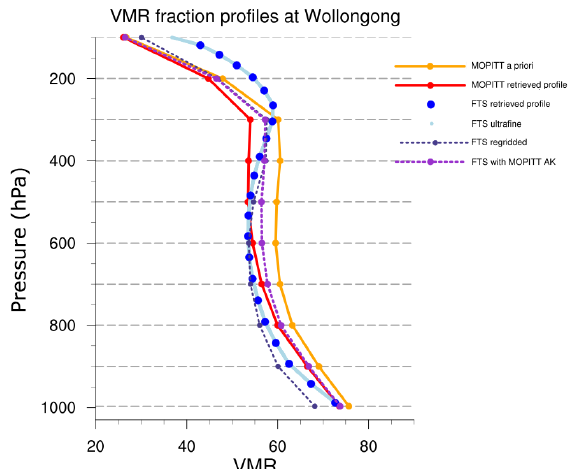
Figure A1. An example of the smoothing technique applying MO- PITT TIR-only AKs to an FTS profile (blue circles) at Wollongong. The FTS profile is interpolated in logP space to an ultrafine grid of 100 levels per MOPITT layer (light blue) and then averaged within each MOPITT layer (blue with dashed line) and smoothed by the MOPITT AK (purple with dashed line) to be commensurate with MOPITT values (red). Dashed grey horizontal lines indicate MO- PITT level